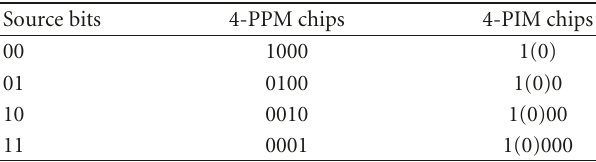
Table 1: Mappings between source bits and transmitted chips for 4-PPM and 4-PIM (Example).